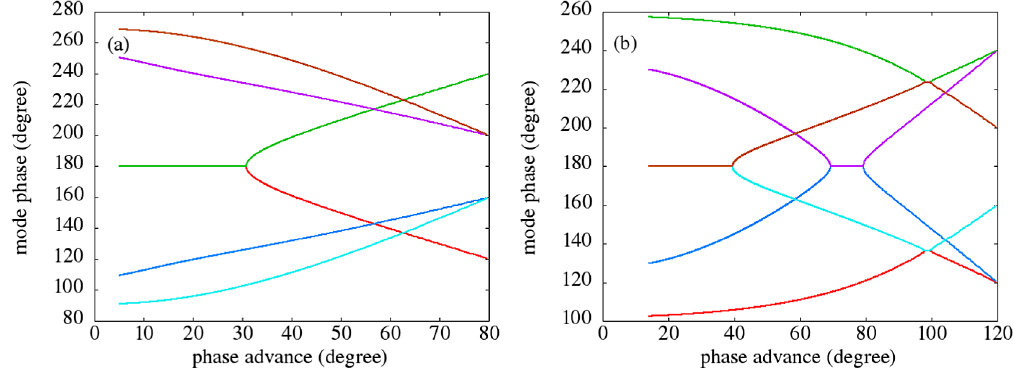
FIG. 6. The 3D envelope mode phases as a function of the depressed transverse phase advance for zero current (a) transverse 80 ° and longitudinal 120 °, (b) transverse 120 ° and longitudinal 80 ° phase advance in a periodic solenoid channel. The six colors are the phases of the six eigenvalues.